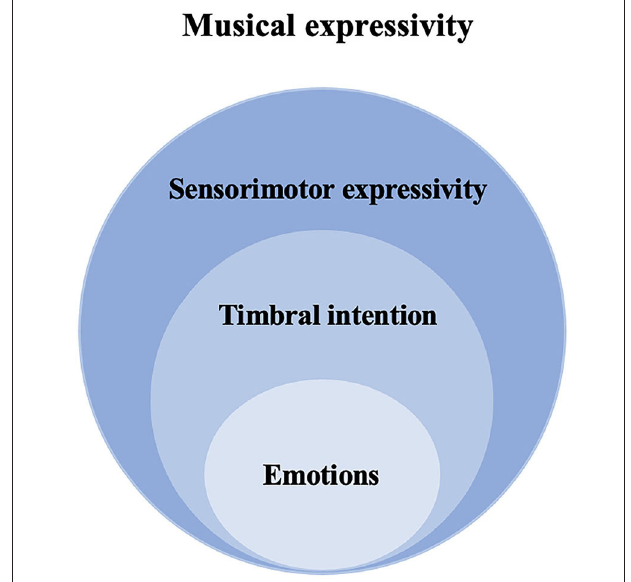
FIGURE 1 | Logic relationship between timbre, emotion, and musical